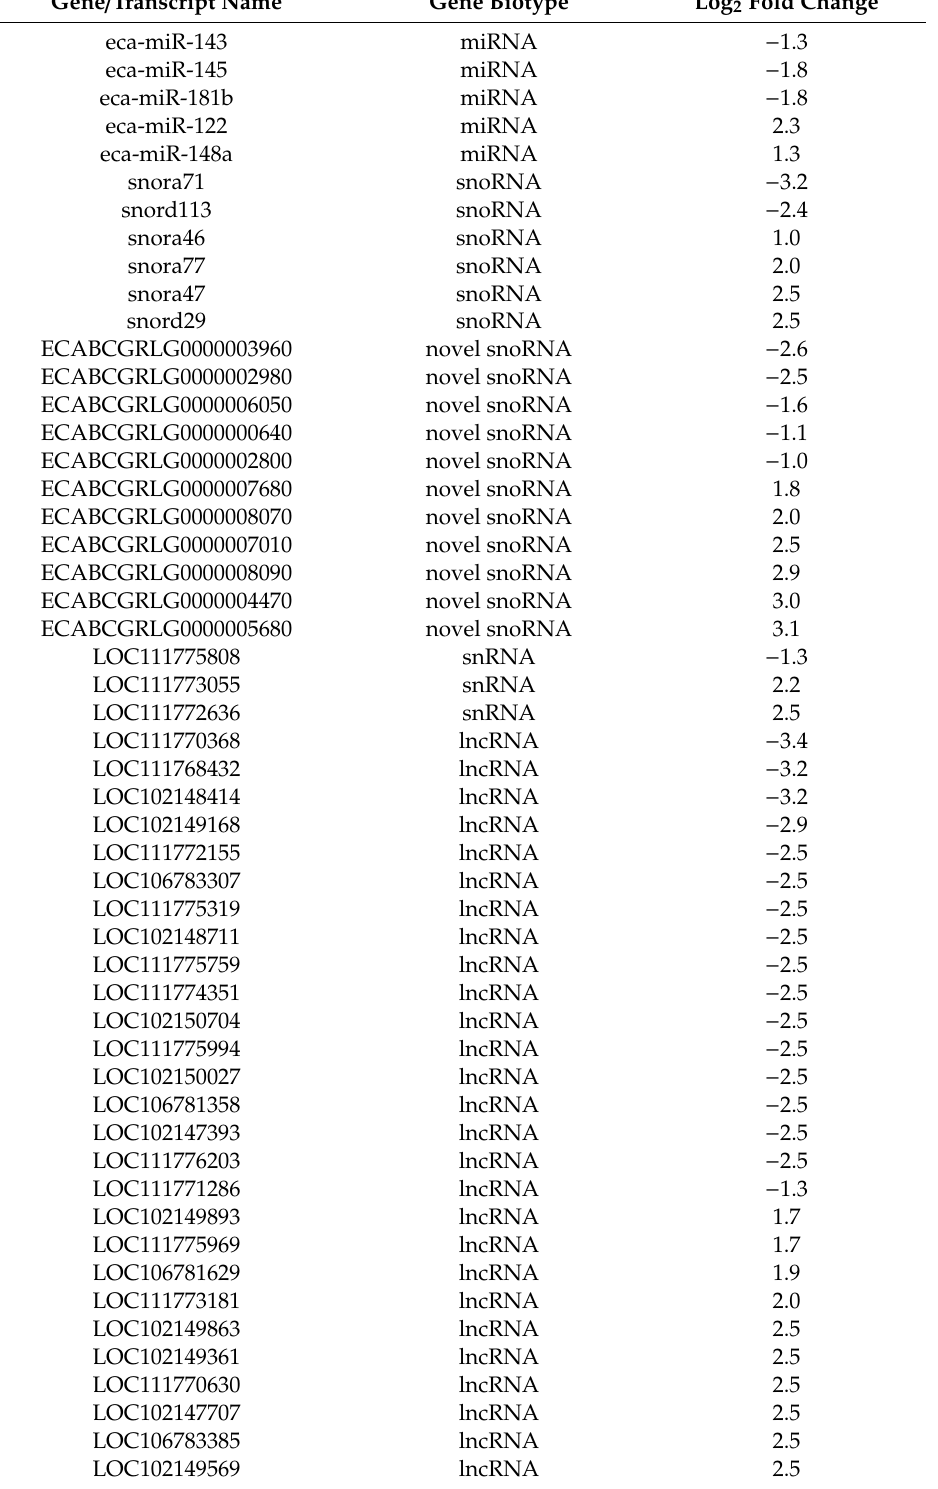
Table 1. Di ff erentially expressed sncRNAs in ageing chondrocytes. Log 2 fold change values were derived with young as the reference group. A positive log 2 fold change equates to higher expression in old, whereas a negative log 2 fold change equates to lower expression in old. All are significant at p < 0.05, except for miRNAs that are significant with a false-discovery rate (FDR-)adjusted p value of p <